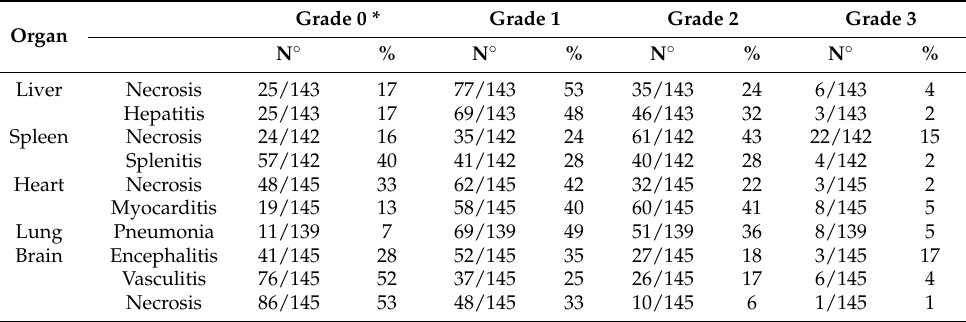
Table 3. Distribution of H&E lesion grades in various most affected organs of blackbirds infected with